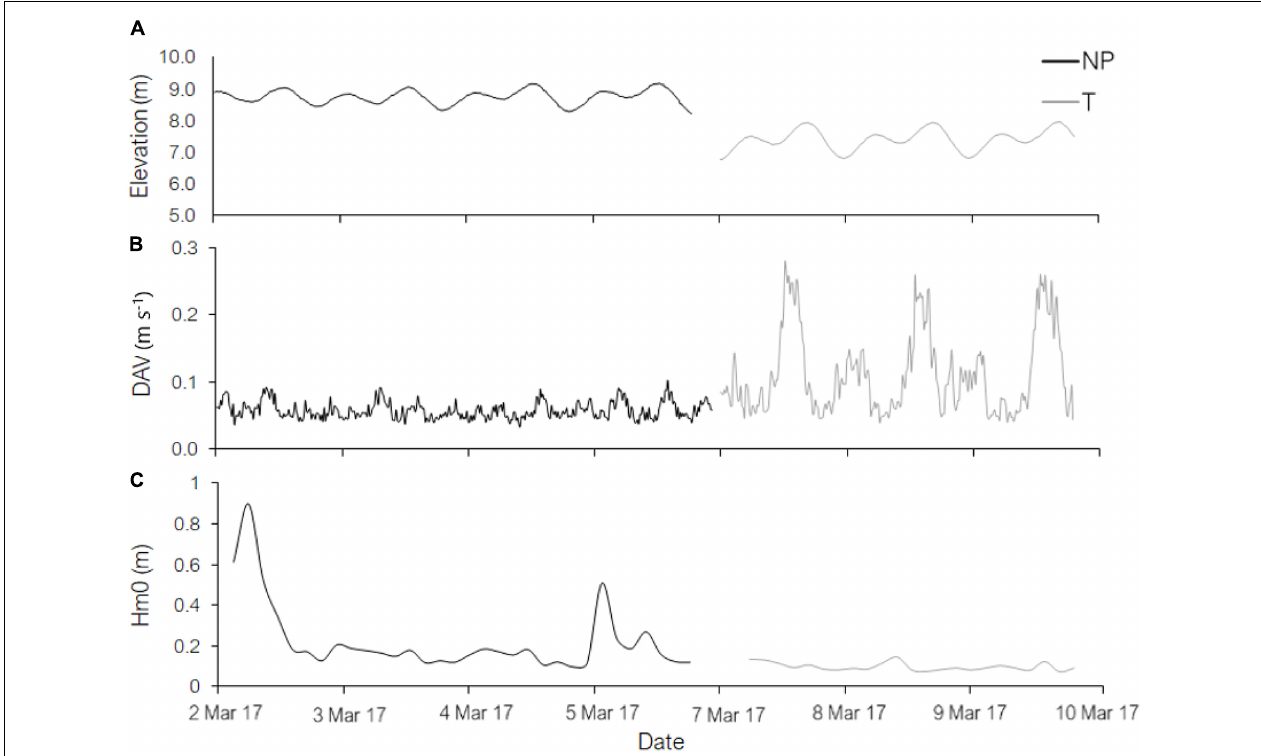
FIGURE 1 | Time series of (A) surface elevation, (B) depth averaged velocities (DAV), and (C) significant wave height (Hm0) at Ninepin Point (NP) (March 2nd – 6th, 2017) and Tinderbox Nature Reserve (T) (March 7th – 10th, 2017) recorded with an Acoustic Doppler Current Profiler (ADCP).